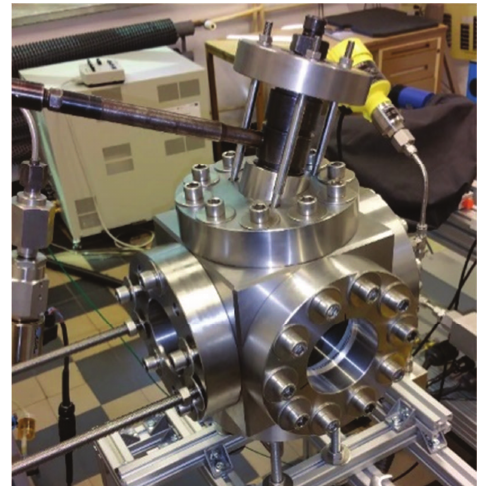
Fig. 1. Constant volume vessel with injector on the top